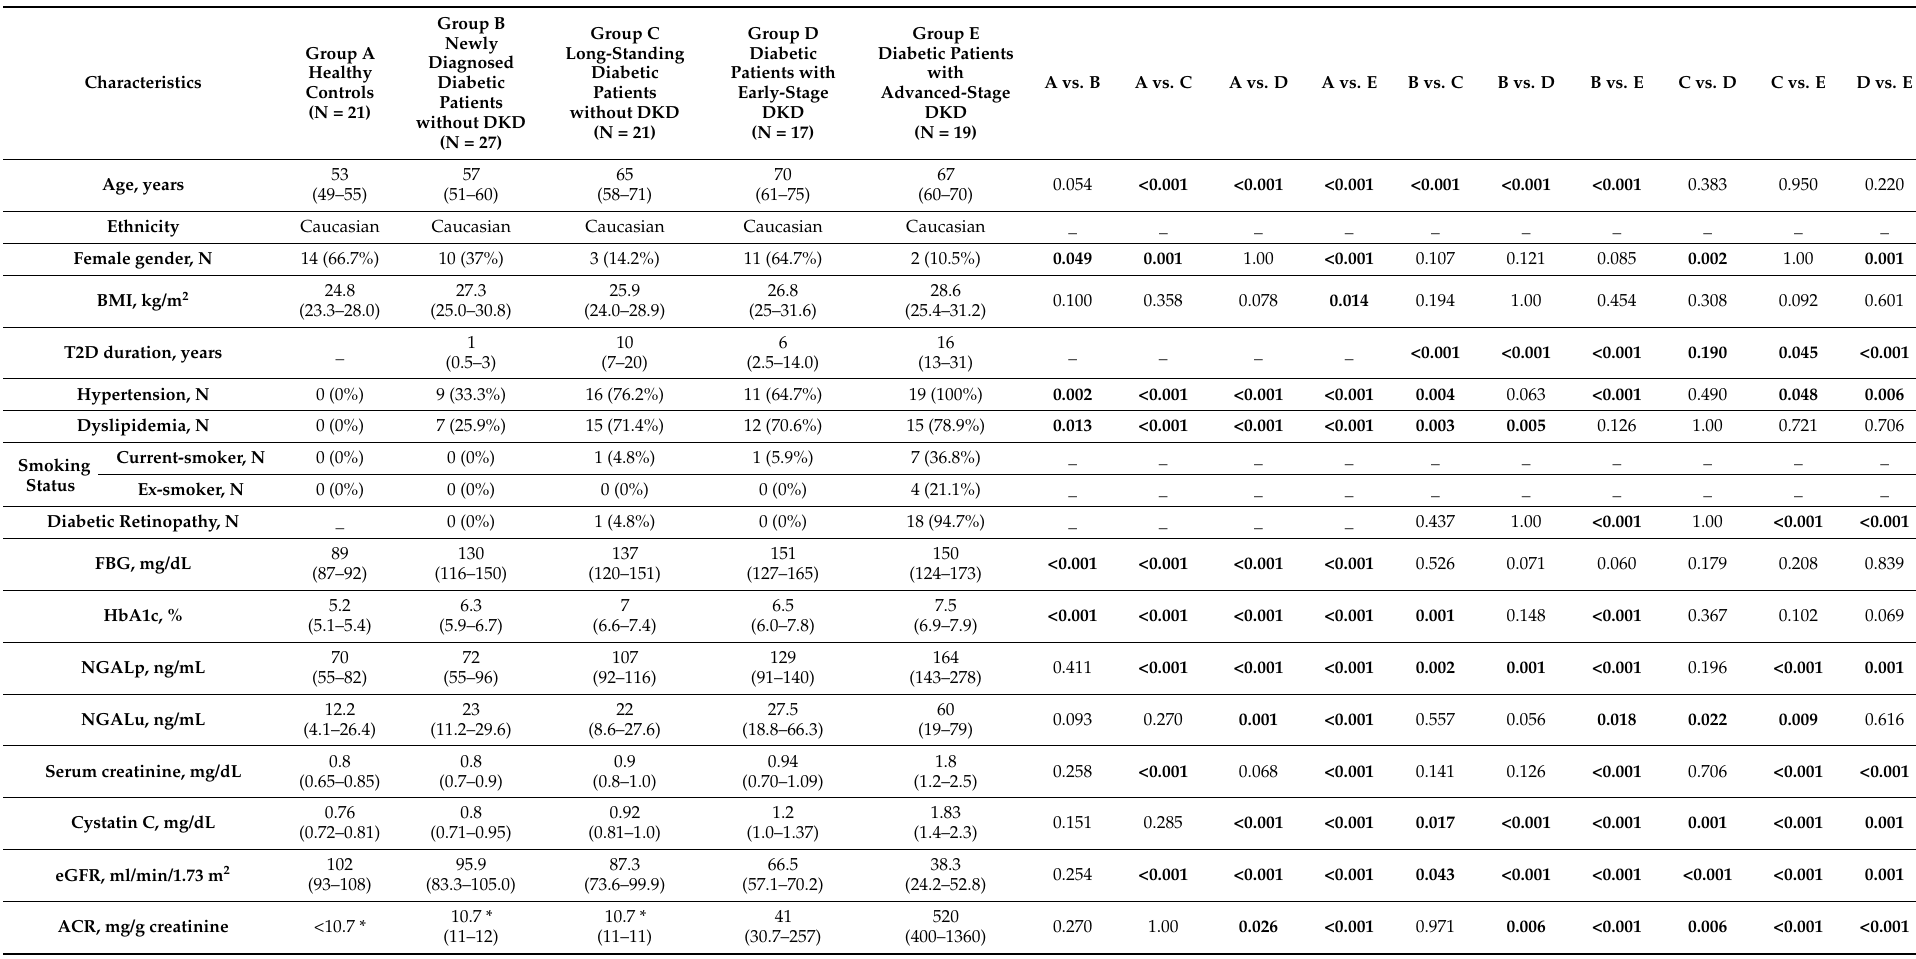
Table 1. Characteristics of the study population according to the presence or absence of DKD, DKD severity and duration of